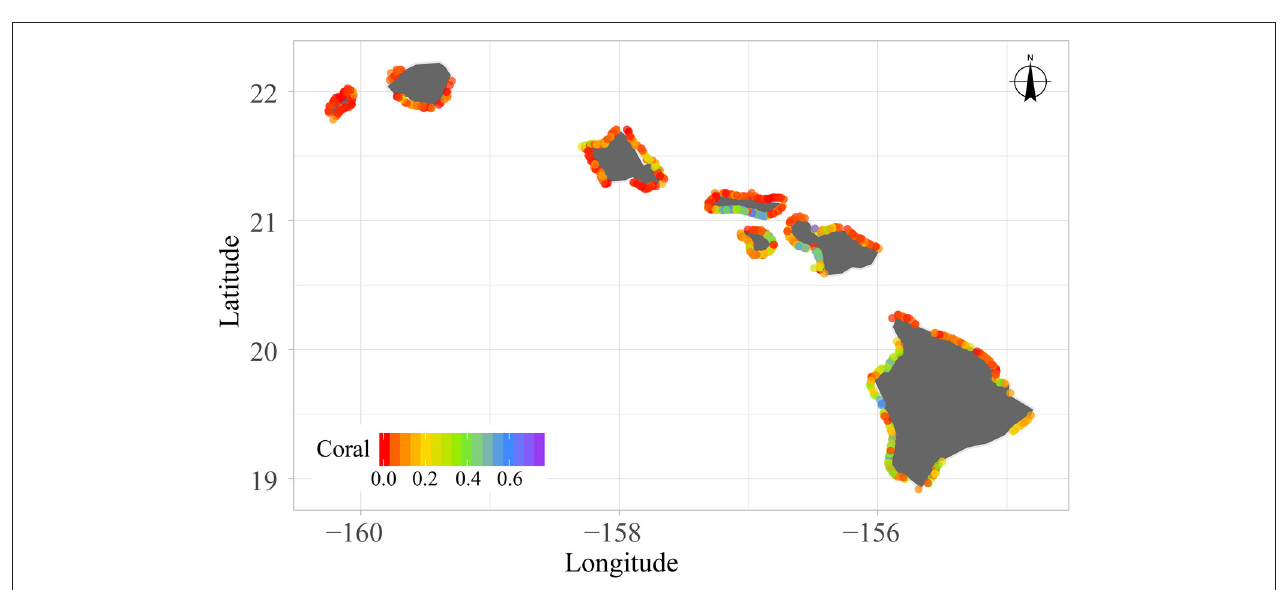
oceanographic variables (e.g., mean SST was correlated with other temporally averaged metrics of SST, but not with any other oceanographic variable) as well as within the full suite of substrate complexity measures (Supplementary Table